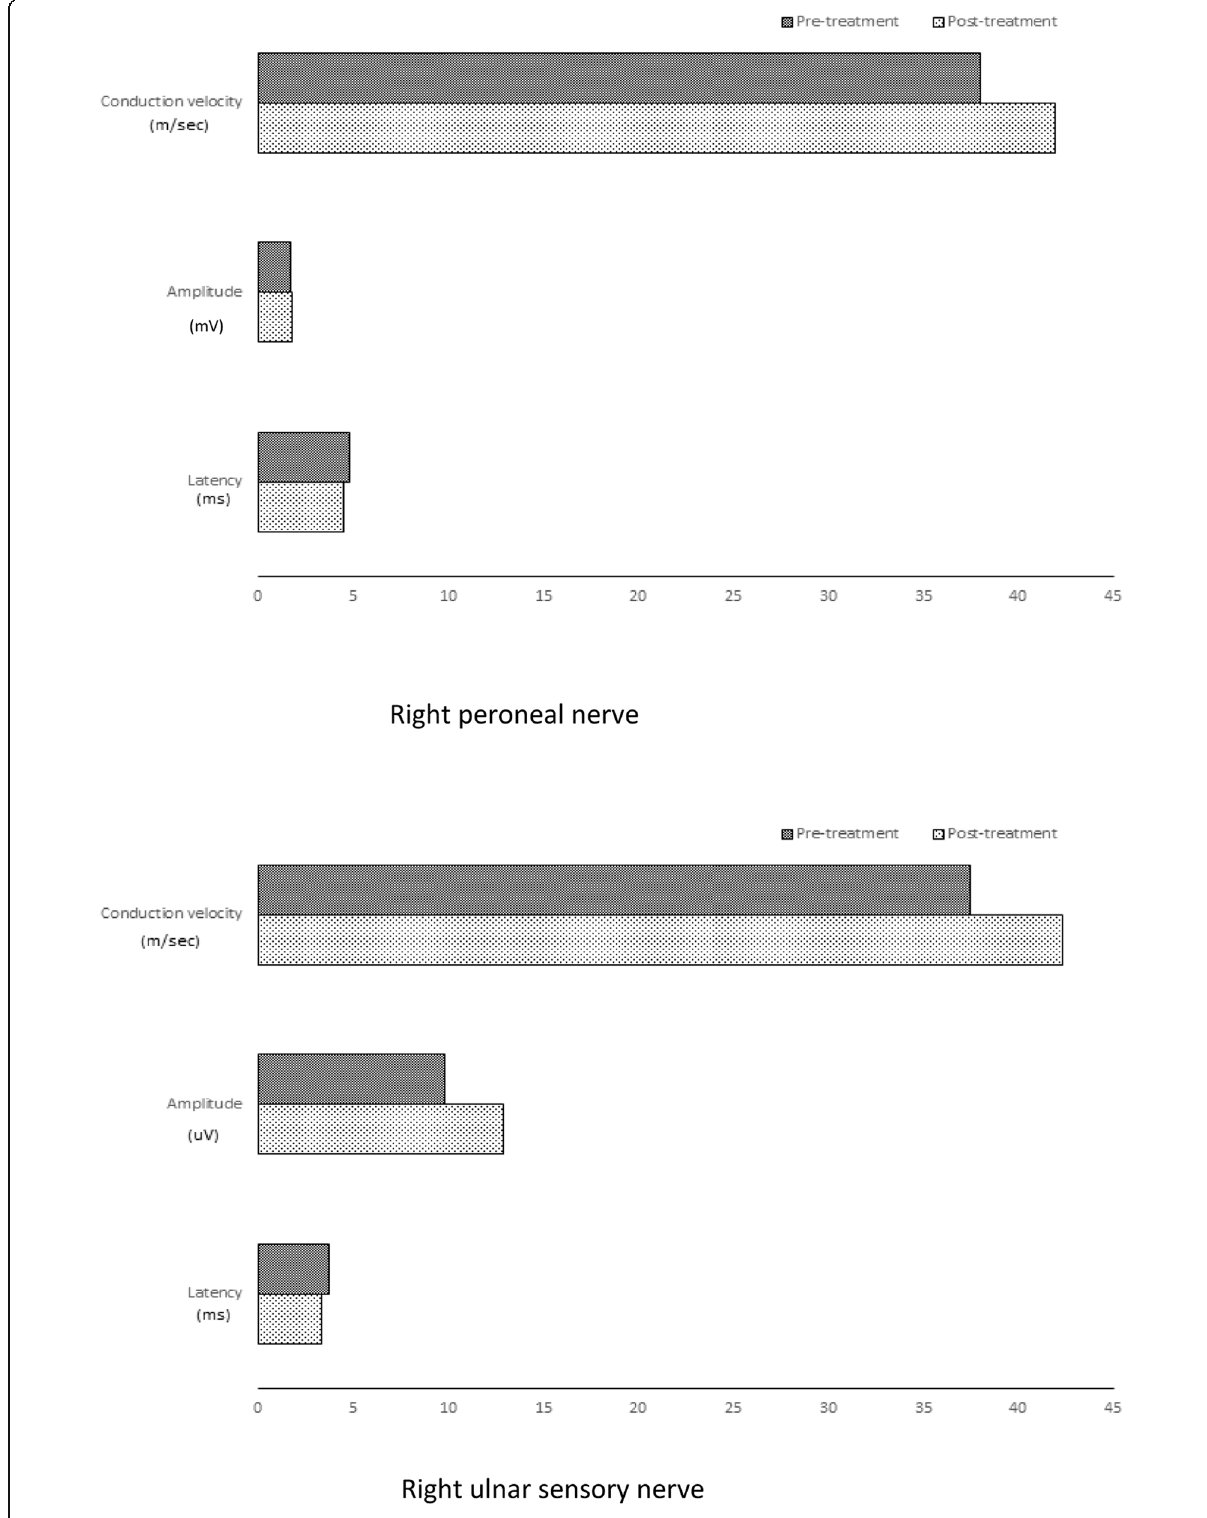
Fig. 2 Change in nerve conduction following rTMS in the insulin-dependent cohort (group